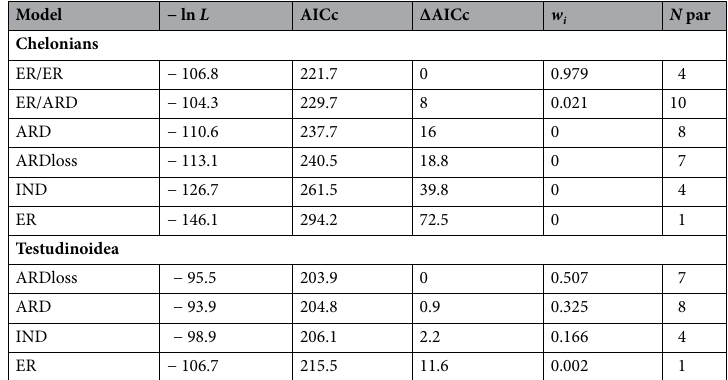
Table 3. The fit of alternative models of the joint evolution of mental glands (absent/present) and macrohabitat (aquatic/terrestrial) in all chelonians and in Testudinoidea, based on Akaike scores and weights derived from the log–likelihoods of the models. N par. indicates the number of estimated transition rates. ARD—distinct rates for all transitions between states (“all rates different”); ARDloss—ARD model with Q1 = Q6; IND—independent evolution between traits; ER—all transition rates equal; ER/ER—a model using the generalized hidden Markov process, consisting of two ER transition matrices; ER/ARD—a model using the generalized hidden Markov process with ARD and ER transition matrices.